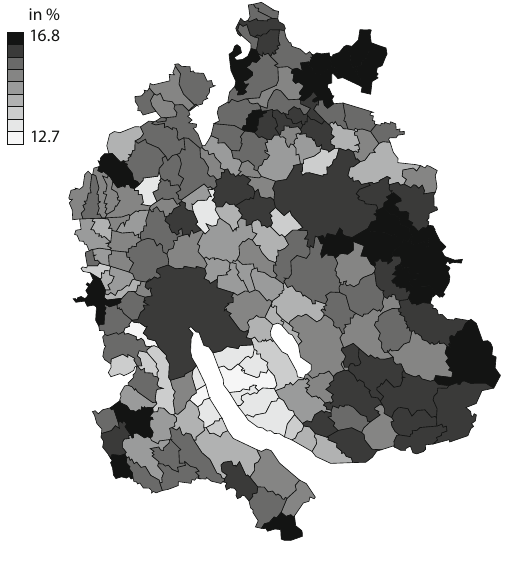
Figure 5: Consolidated cantonal (cid:2) municipal effective average tax rate across municipalities in the canton of Zurich in 2014 for a married couple with two children and top-1%